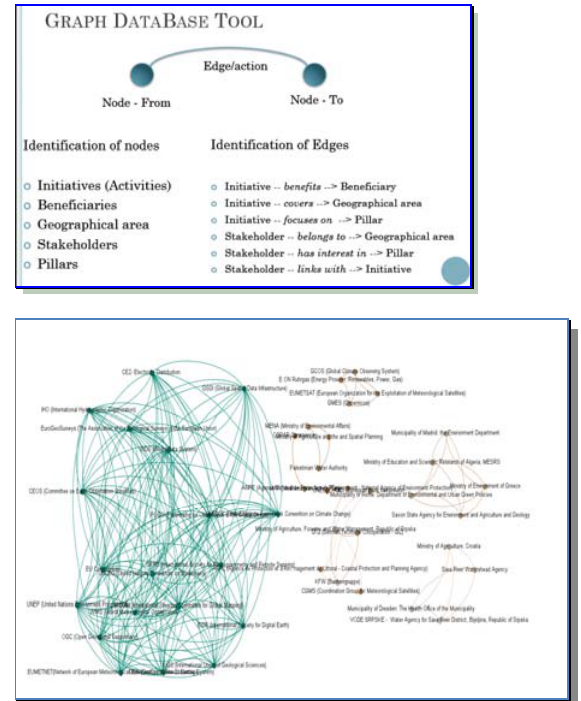
Figure 6. An example of Network Analysis